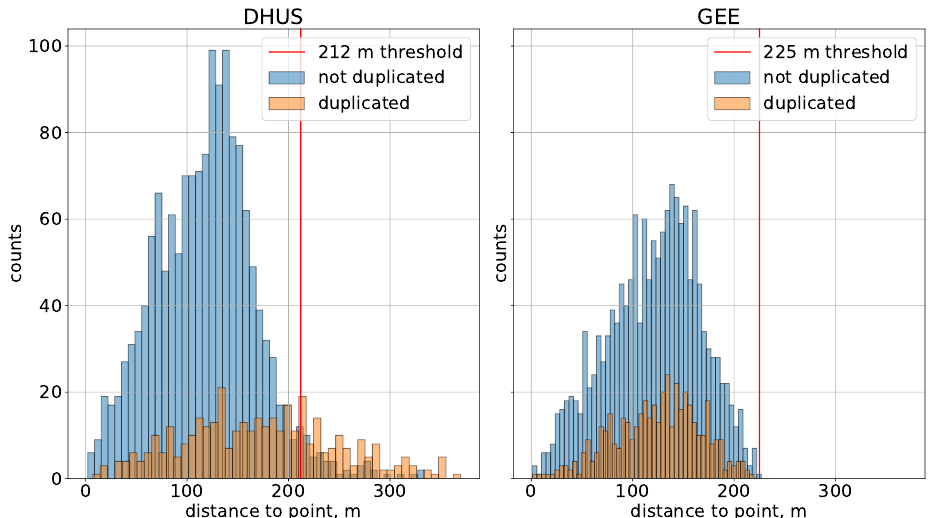
Figure 3. Distance from the extracted pixels to the point of interest. The red line denotes the theoretically acceptable threshold. See Section 3.1.